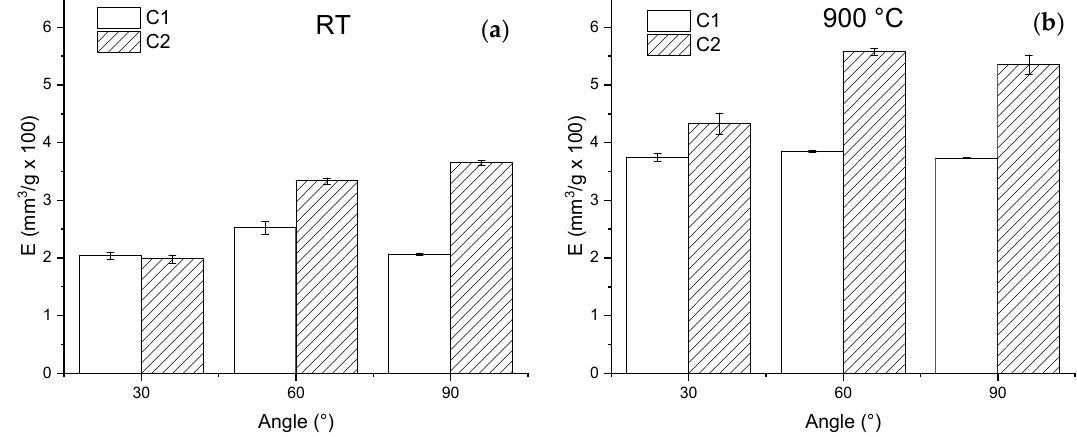
Figure 8. Volumetric erosion rate plots ( a ) at room temperature and ( b ) at 900 °C.